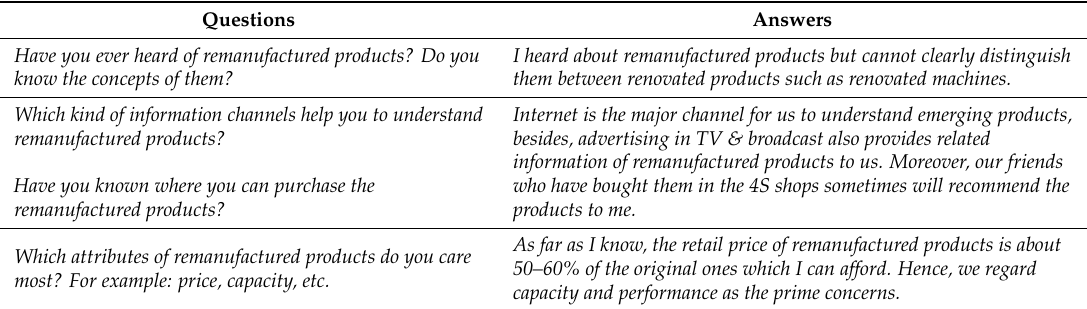
Table 6. Quotations of questions and answers in